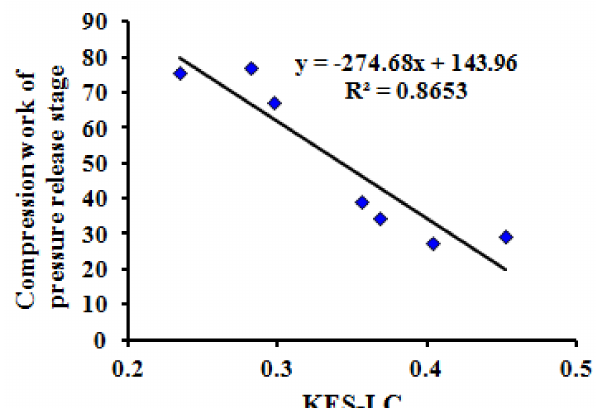
Figure 9. Relationship between compression work of pressure release stage ( W CA ) of MTT test and KES compression test.